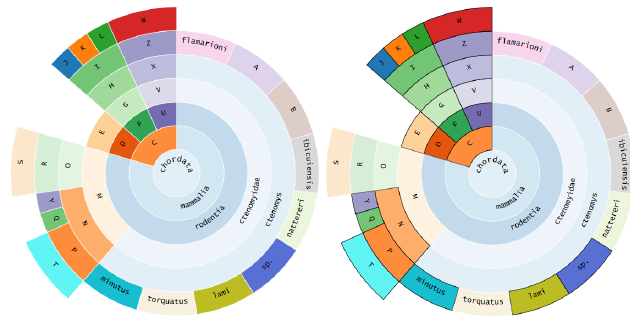
Figure 12. Previous style of visual feedback for selection (left) compared to the new proposed style on the Sunburst visualization (right).